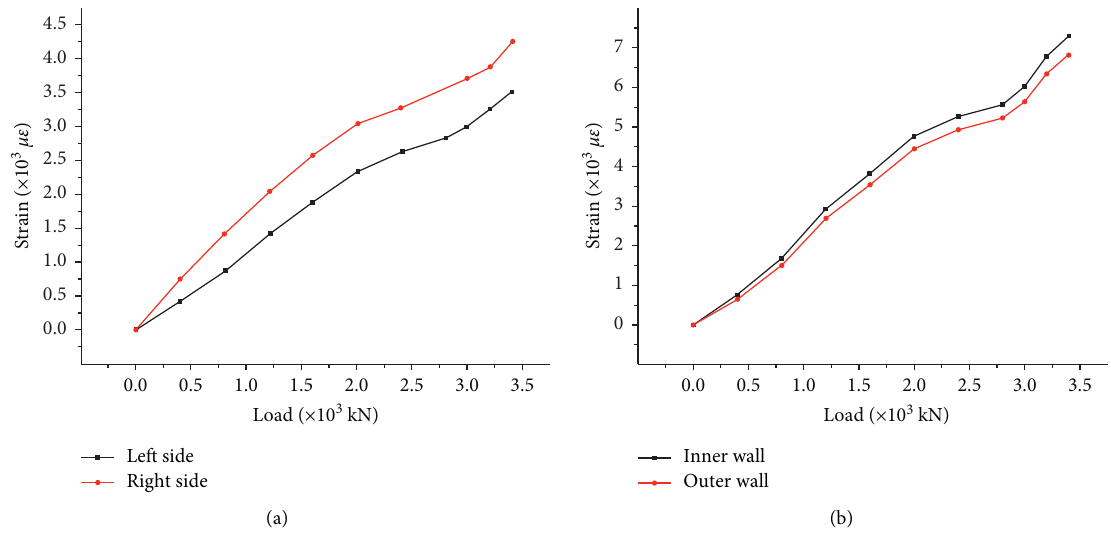
Figure 16: The comparison of deflections at different parts: (a) the midspan of both sides of the wall; (b) the left side in the middle of the inner wall and the outer wall.